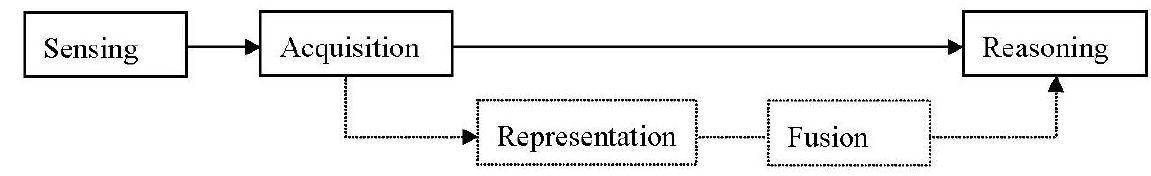
Figure 1. The context-aware systems‘ design and development process and our proposed extension to streamline (represented by dotted lines and boxes) the overall scheme by introducing context representation and